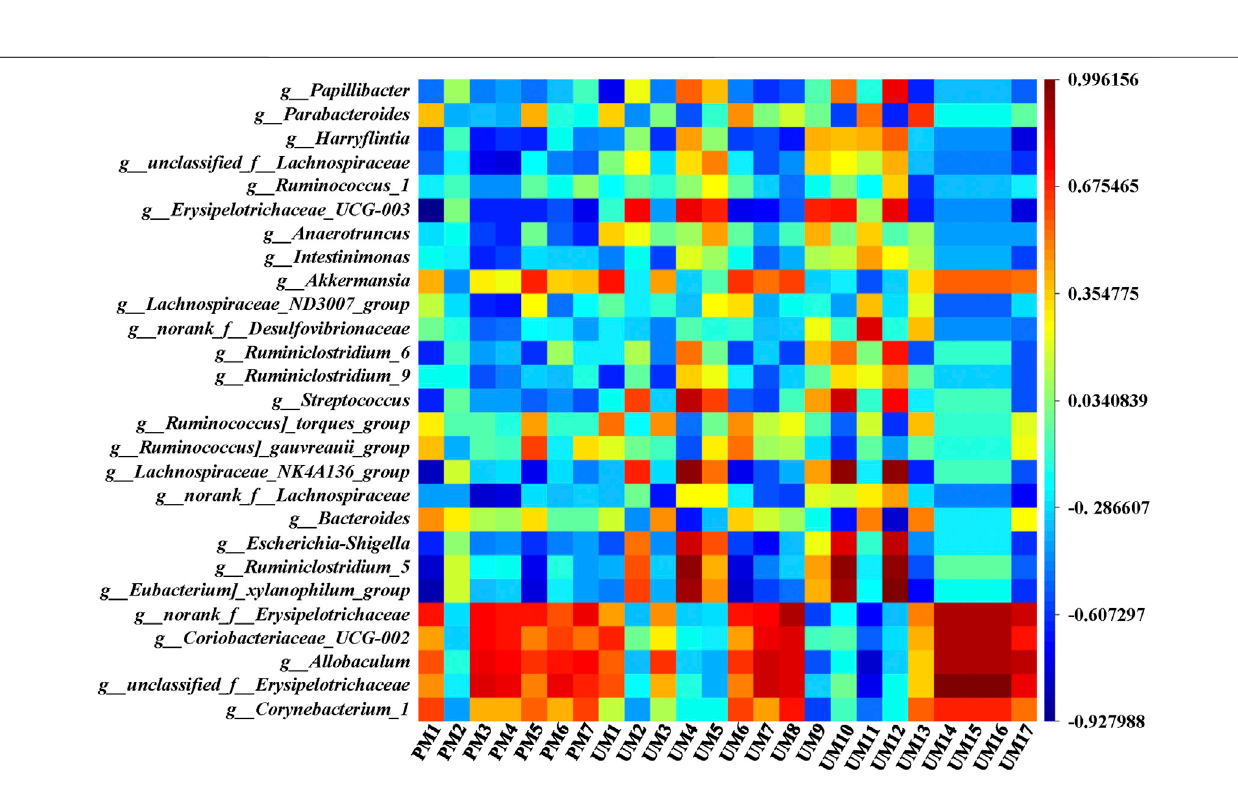
Frontiers in Pharmacology |